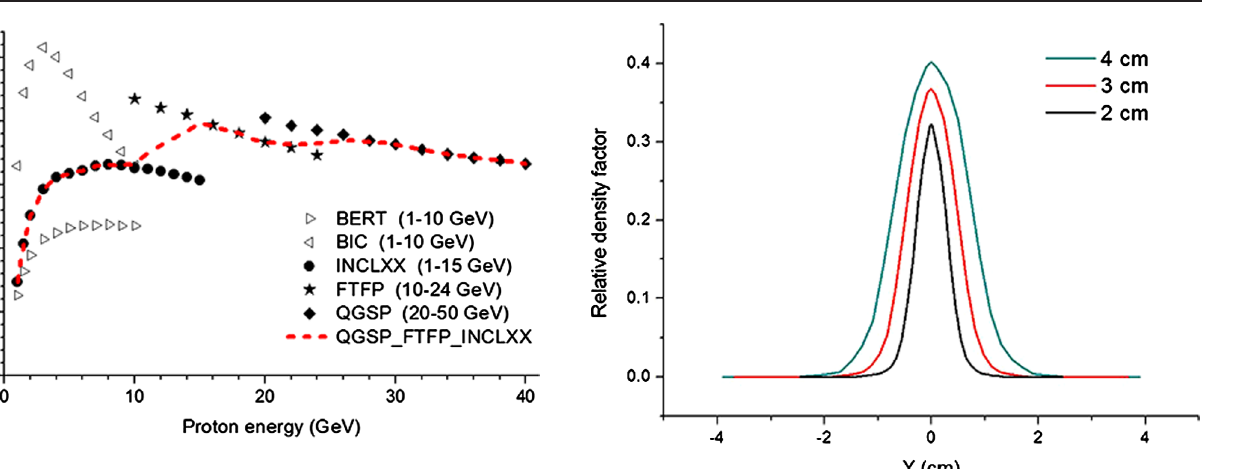
FIG. 5. Total production of charged pions (per proton per GeV) produced in target body of proton beams with various kinetic energies simulated using different hadronic models.